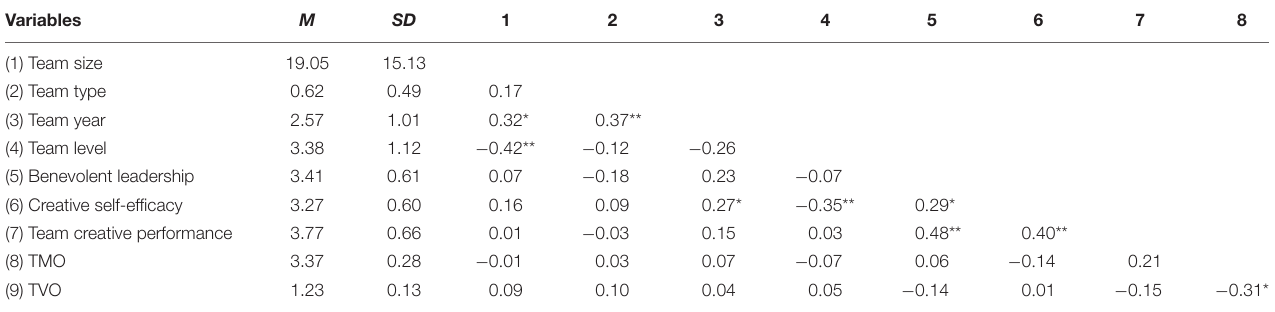
TABLE 1 | Means, standard deviations, and correlations among variables.